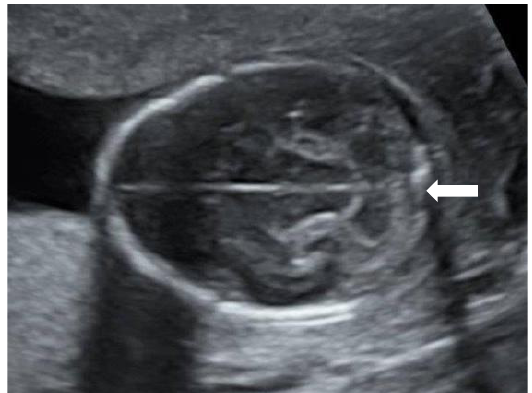
Figure 1. Subtle posterior curving of the cerebellum at 17 weeks.